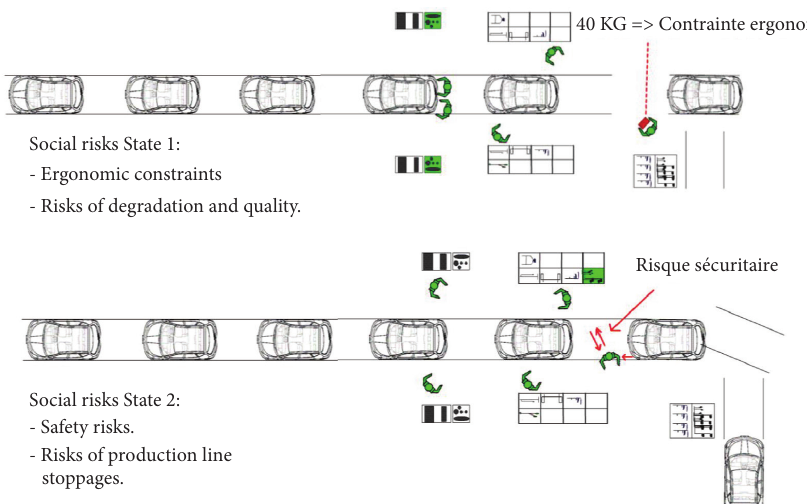
Figure 15: Explanatory diagram of the positions affected by a Lean. Table 2: Result of the descriptive analysis of the survey.